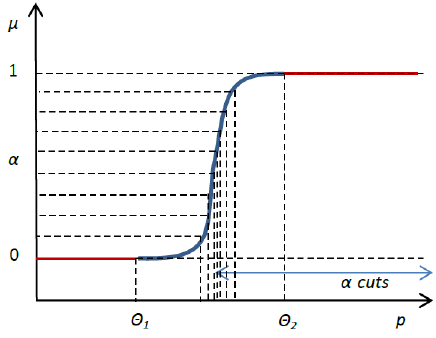
Figure 4. Concept for α -cut sampling and sigmoid function.